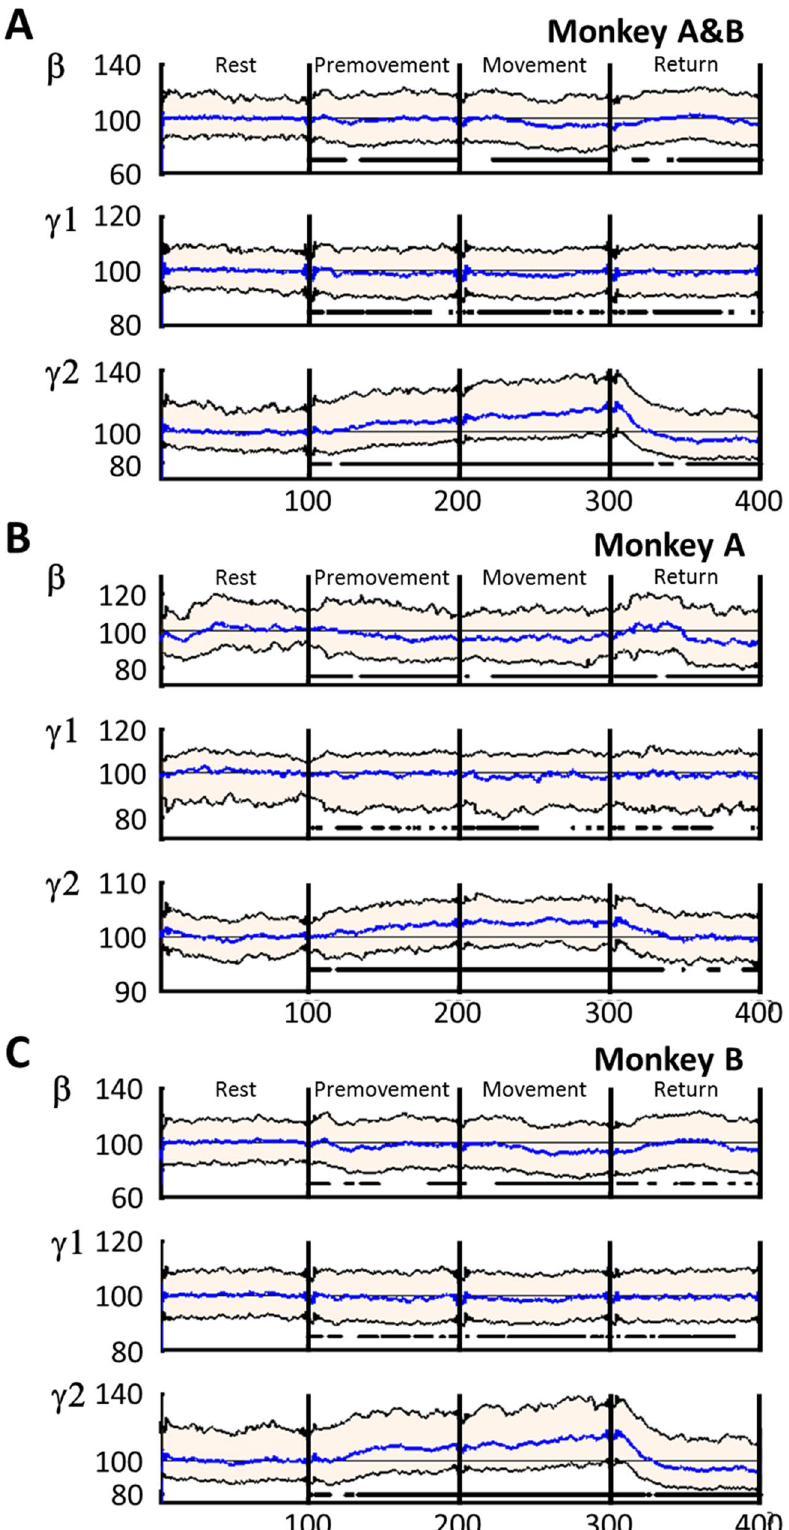
Figure 4. The β (13–30 Hz), γ1 (30–80 Hz), and γ2 (80–200 Hz) band activity changes during motor task periods (Rest, Premovement, Movement, and Return) with DBS-OFF. ( A ) Monkeys A and B combined. ( B ) Monkey A. ( C ) Monkey B. The activity in each band was calculated using the Kalman filter and normalized to the median activity during Rest (% of base line, BL). Time was normalized to 100 time units in each period (total, 400 relative time units). Purple, median; blue, median activity during the Rest period; black borders of pink area, interquartile range (25th to 75th percentiles); horizontal, interrupted thick black lines in the bottom indicate significant differences from the Rest period ( P <